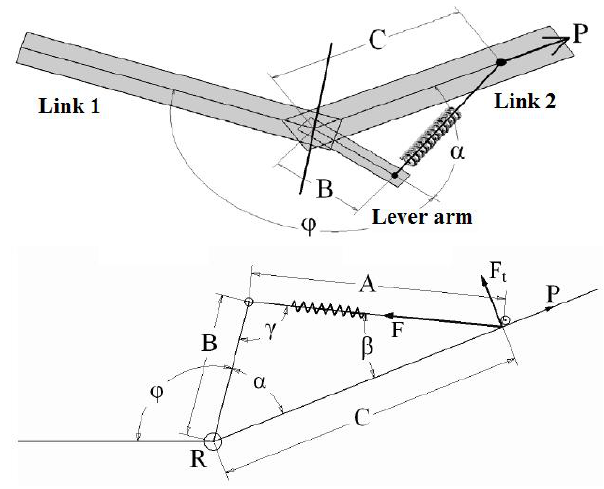
Figure 1. The working principle and scheme of the mechanically adjustable and controllable equilibrium position actuator (MACCEPA) [21].